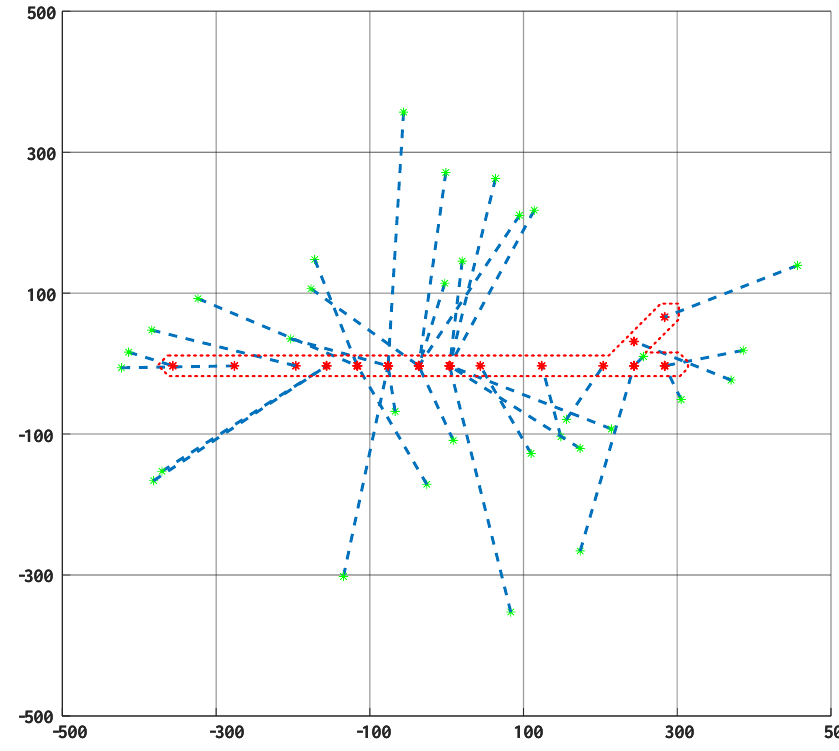
Figure 6. The X–Z perspective of topology shaping in aircraft